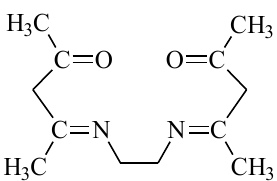
Figure 1. The chemical formula of ethylenodiamino-bis-acetylacetone (EDAB-acac).